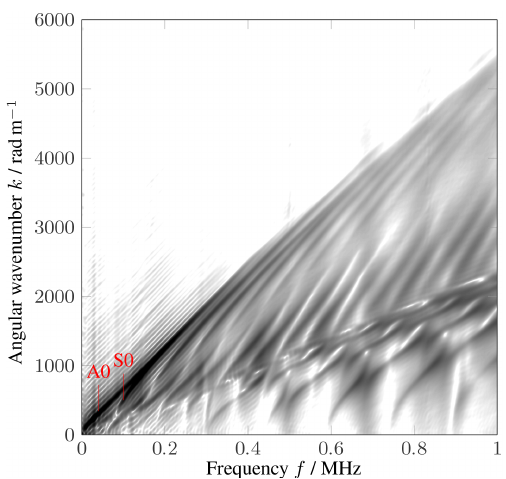
Figure 9. Dispersion map of a polymer plate (polyamide 6, thick- ness 8.8mm). Generated by applying the two-dimensional FFT to spatially and temporally resolved data.